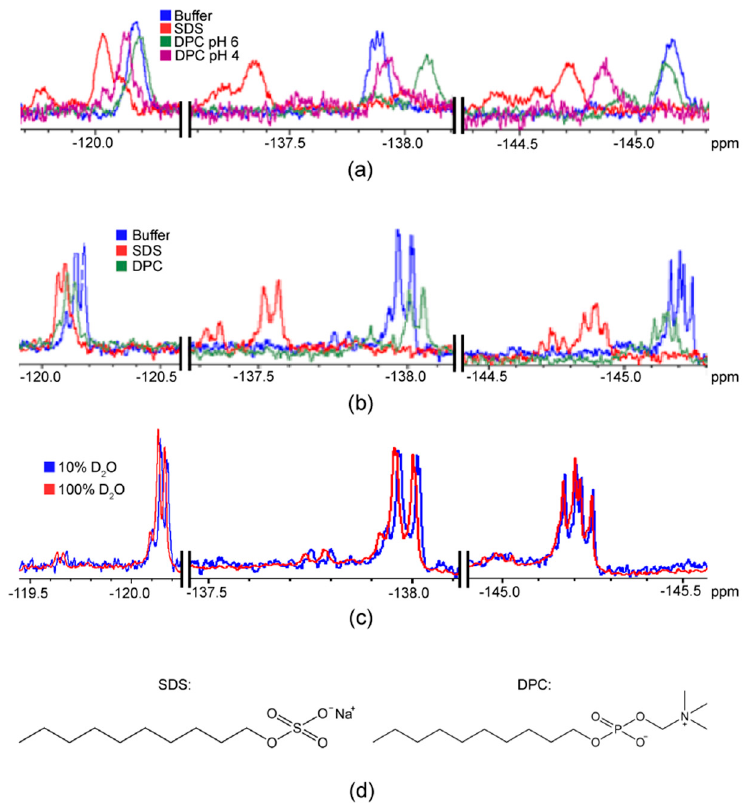
Figure 3. 19 F nuclear magnetic resonance (NMR) spectra of ( a ) F*-ap-13 and ( b ) F*-ap-17 under indicated experimental conditions. ( c ) F*-ap-17 in buffer with 10% D 2 O:90% H 2 O vs. 100% D 2 O. ( d ) Sodium dodecyl sulfate (SDS) and dodecylphosphocholine (DPC) structures.